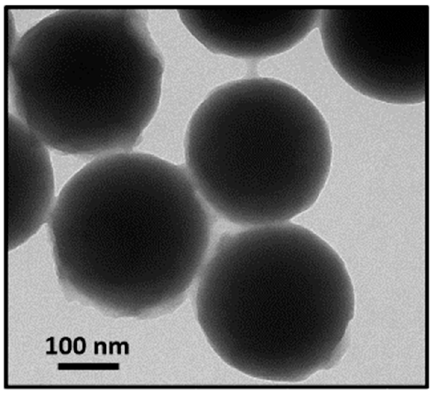
Figure 5. Transmission electron microscopy (TEM) micrographs of CSNPs.